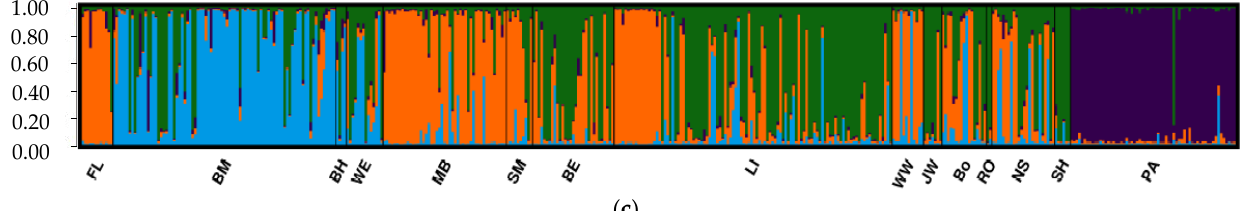
Figure 2 . Detecting the most likely number of genetically distinct groups within yellow-bellied toads in the northern Weser Hills based on ( a ) mean L(K) ± SD over 20 runs per K, ( b ) Maximum likelihood estimation of K [30] and ( c ) percentage of population assignment of K = 4. Each individual is visualized as a single line. Coloration indicates the membership of the individual to the given cluster (“G”). G1 (orange) = FL, WW, NS, BO, SM, MB. G2 (green) = WE, LI, JW, BE, RO, SH. G3 (blue) = BM, BH. G4 (purple) = PA.